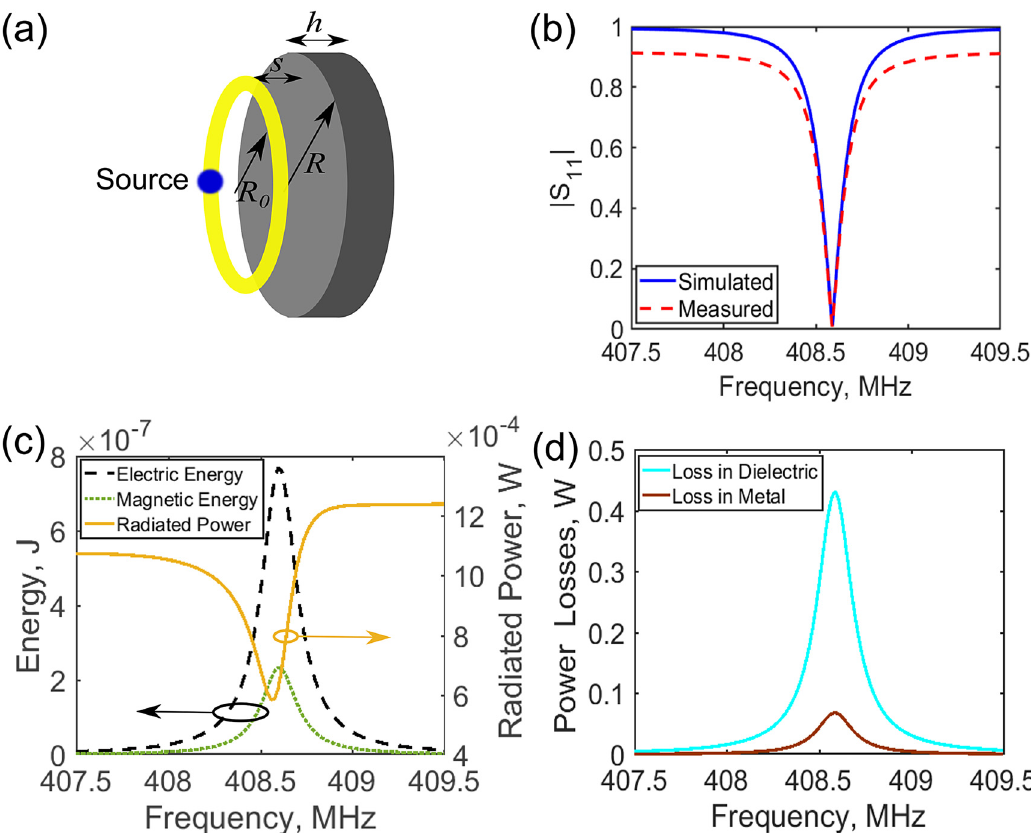
Figure 1: NR source design.